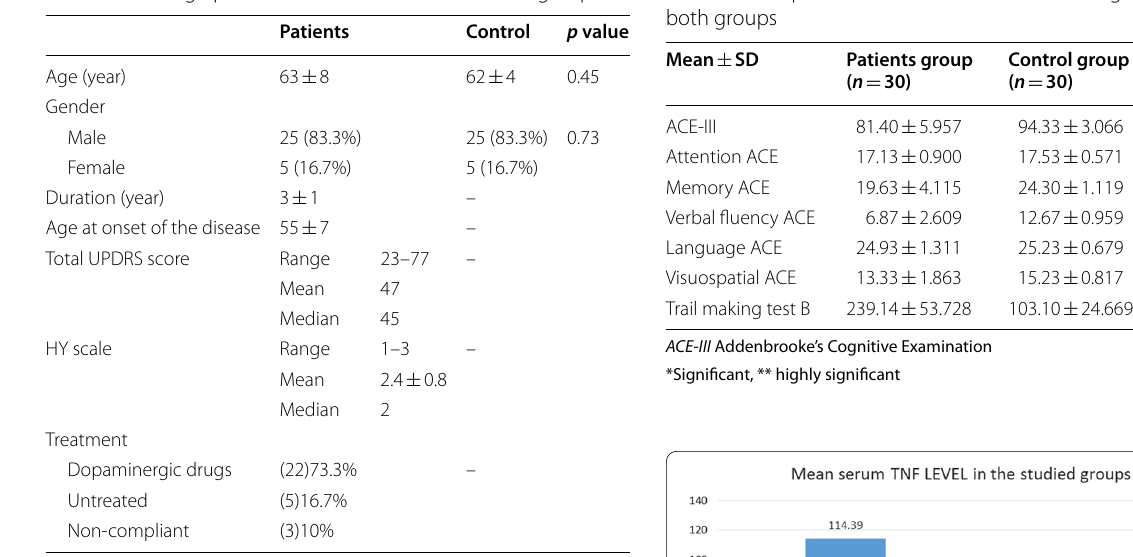
Table 1 Demographic and clinical data of the studied groups